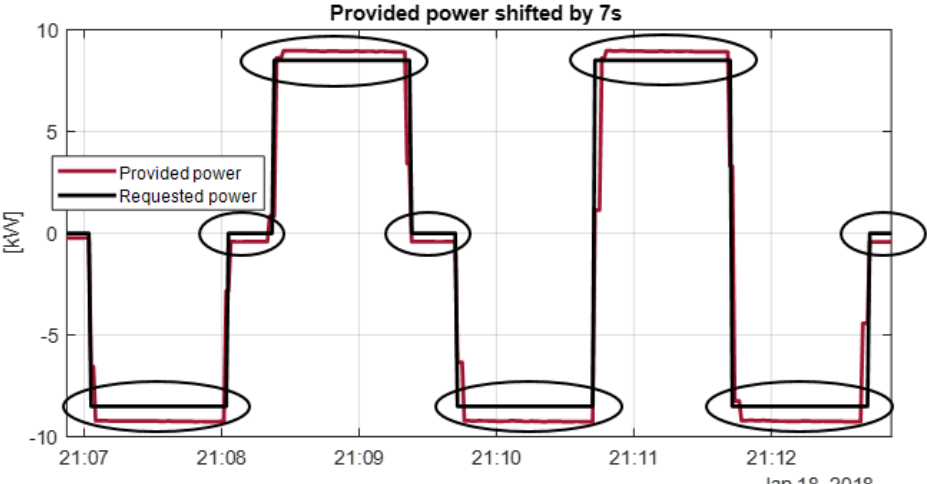
Figure 10. For both accuracy and precision the calculation is done during the constant set-point levels of the step-wise portion of the tested cycles. This means at zero set-point at the maximum charging ( − 8.5 kW) and discharging power (+8.5